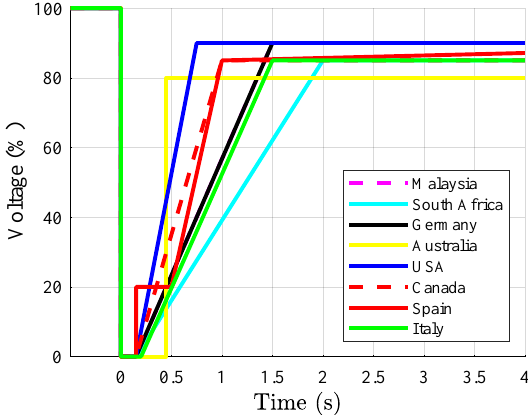
Figure 6. ZVRT requirements implemented in various grid codes.